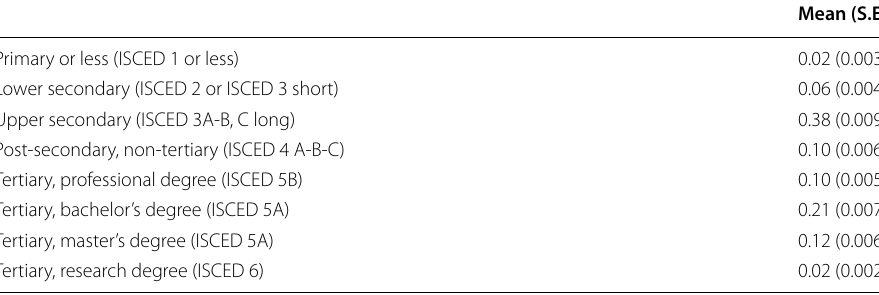
Table 7 Highest Level of Education by ISCED classification, All Workers PIAAC 2012/2014